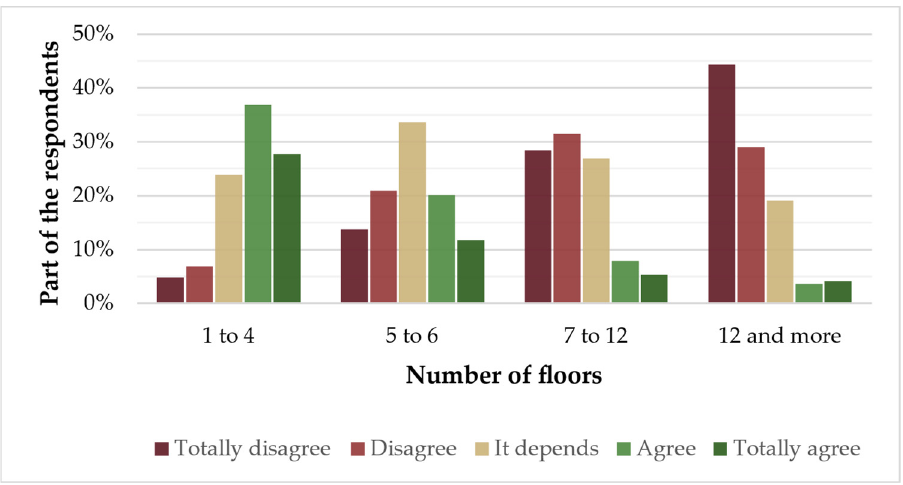
Figure 5. Acceptance of the use of mass timber in high-rise